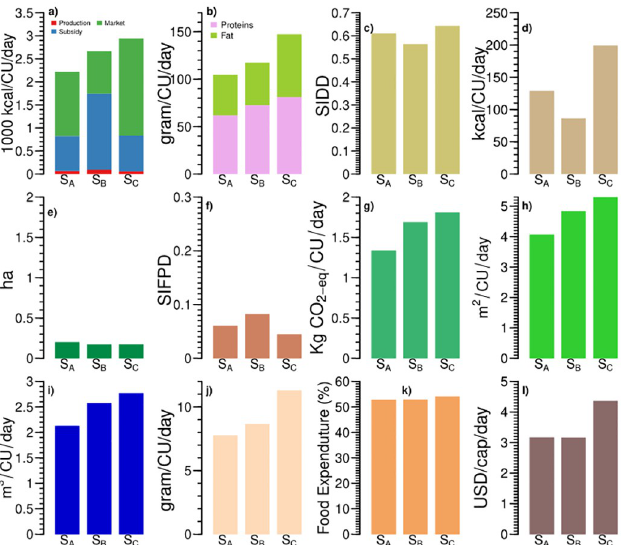
Fig 4. Three subsidy-based food systems (S , S , and S ) of India differ across food systems’ indicators: (a) sources of A B C calorie intake, (b) protein and fat intake; (c) Simpsons Index of Dietary Diversity (SIDD), (d) processed and ready to eat food intake, (e) land cultivated (ha), (f) Simpsons Index of Food Production Diversity (SIFPD), (g) greenhouse gas emissions, (h) land footprint, (i) water footprint, (j) animal protein intake, (k) share of food expenditure, and (l) daily per capita